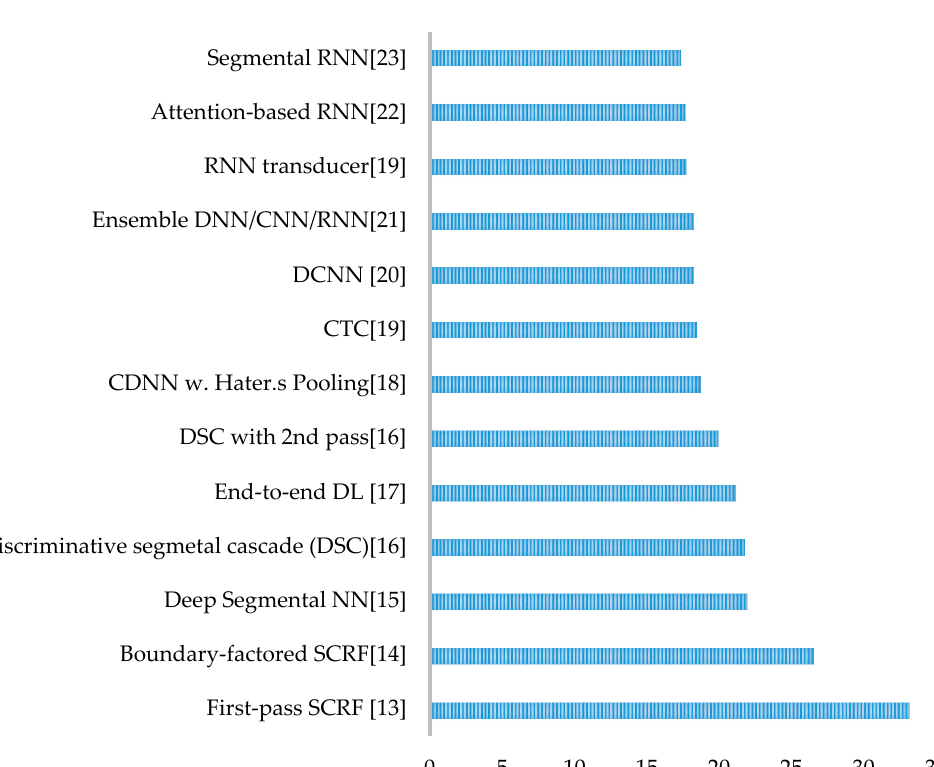
Figure 3. Accuracy for ImageNet classification challenge with different DL models.